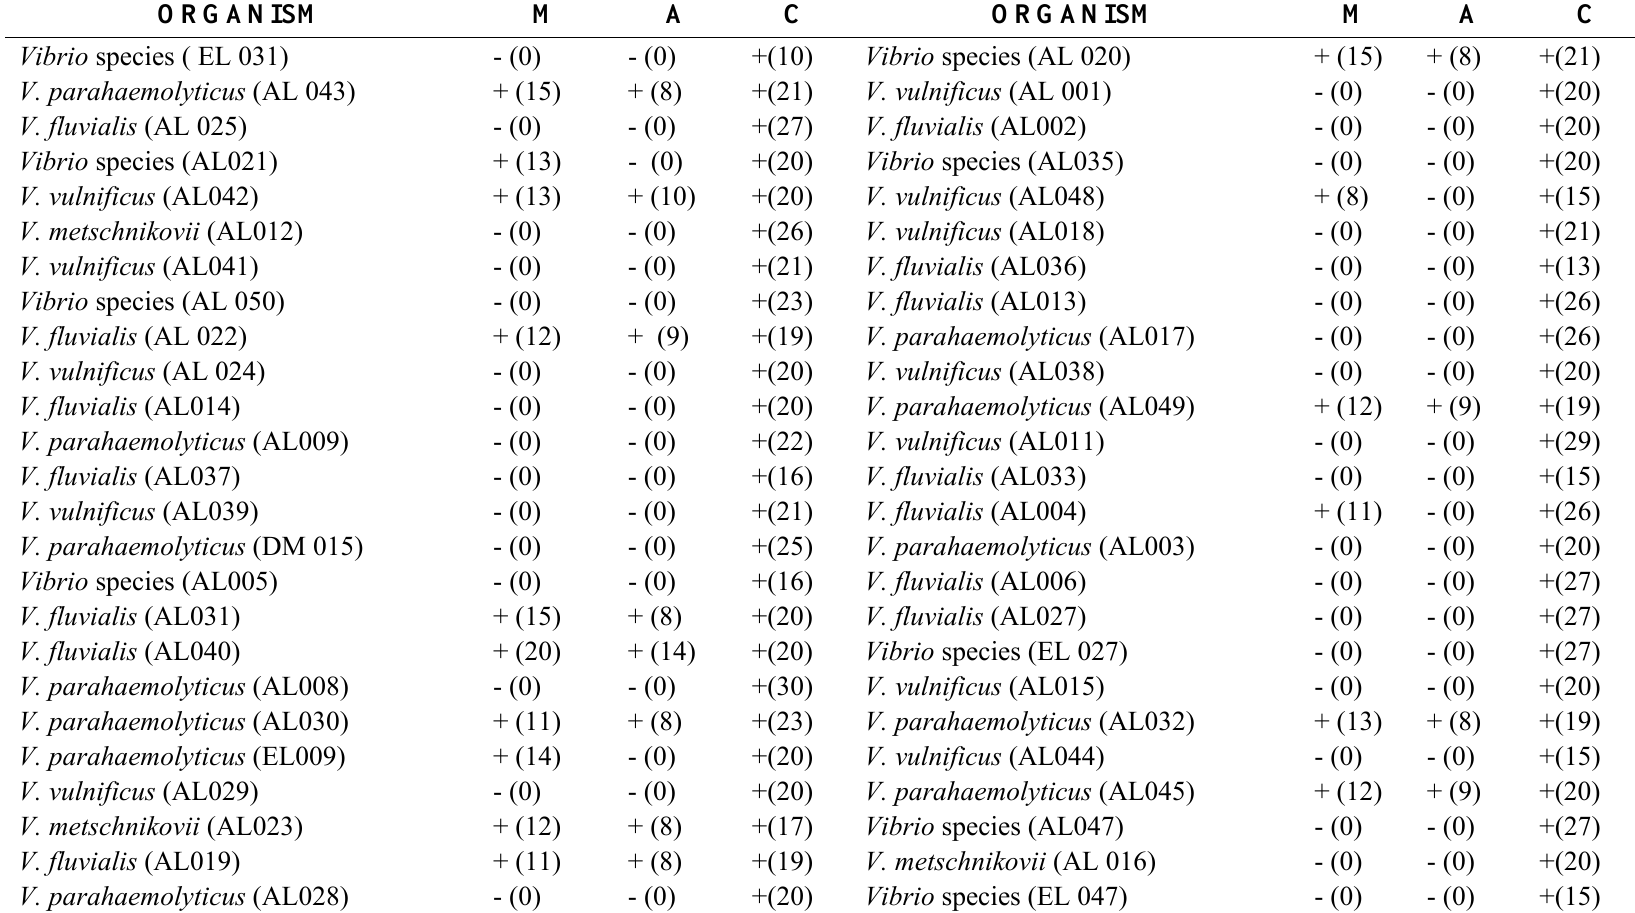
Table 1. Anti- Vibrio activities of Ciprofloxacin and the crude methanol and aqueous extracts of Garcinia kola seeds.